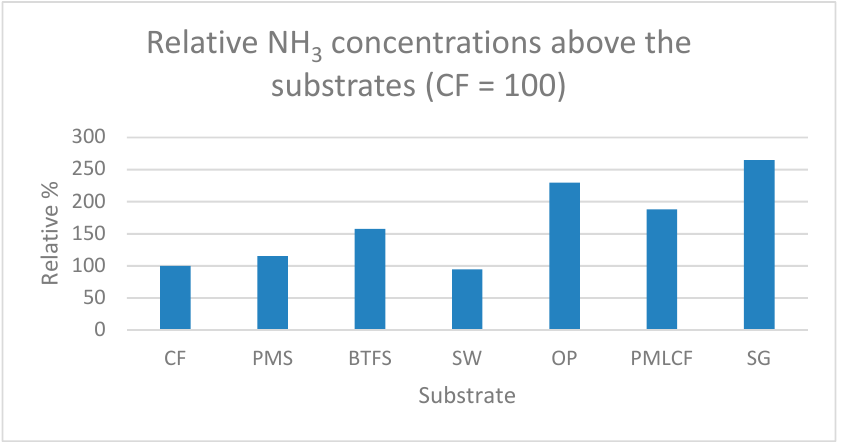
Figure 4. NH 3 concentrations measured above the individual substrates at day 8.